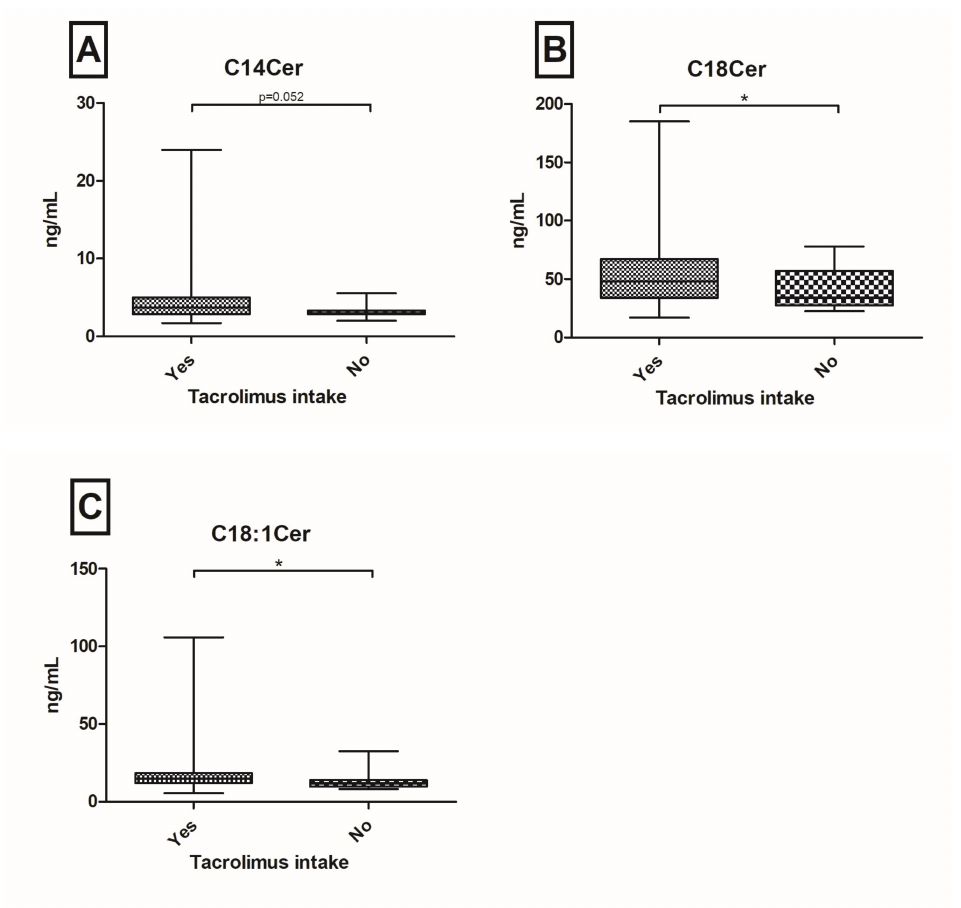
Figure 3. Serum ceramides (Cer) in post-OLT patients. C14Cer ( A ), C18Cer ( B ) and C18:1Cer ( C ) are up-regulated in patients with current tacrolimus intake, compared to no tacrolimus intake (* p <